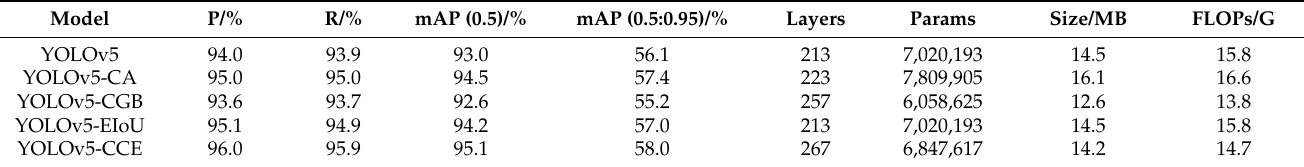
Table 3. Results of different experiments.